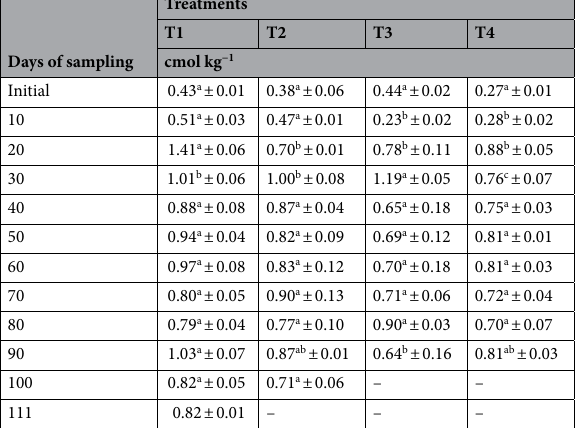
Table 10. Chicken litter biochar on exchangeable H + at one hundred and eleven days after transplanting of MR219. Different letters within a row indicates significant difference between means of four replicates ± standard error using Tukey’s test at p ≤ 0.05.